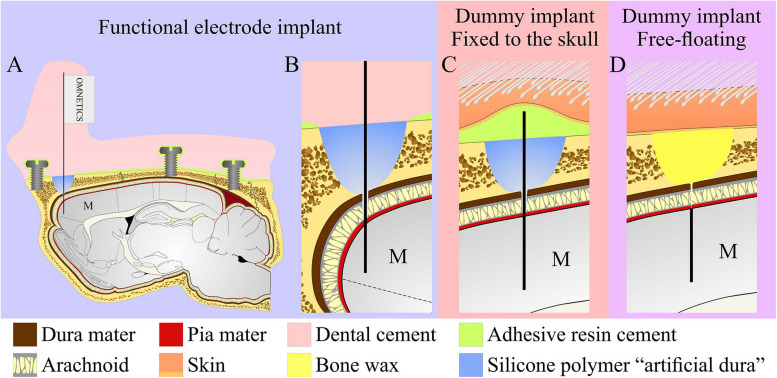
Schematic drawing of the three modes of perforated polyimide MEA platform (PPMP) implantations. (A,B) View of a functional PPMP implant in the sagittal plane. A PPMP attached to an omnetics connector inserted into the motor cortex (M). The dura is protected by silicone polymer (“artificial dura”). The implant is anchored to the skull with 6 screws and adhesive resin dental cement. The holding body of this transcutaneous implant was made of acrylic dental cement. (C) Fixed dummy PPMP implant in the sagittal plane. The dura is protected by a silicone polymer and the electrode platform is fixed to the skull with adhesive resin cement. The skin above the implant is closed after implantation, creating a subcutaneous implant configuration. (D) Free-floating dummy implant in the sagittal plane. The short implant is inserted into the motor cortex. The dura and opening in the bone are protected by bone wax and the skin above the implant is closed after implantation creating a subcutaneous implant configuration.